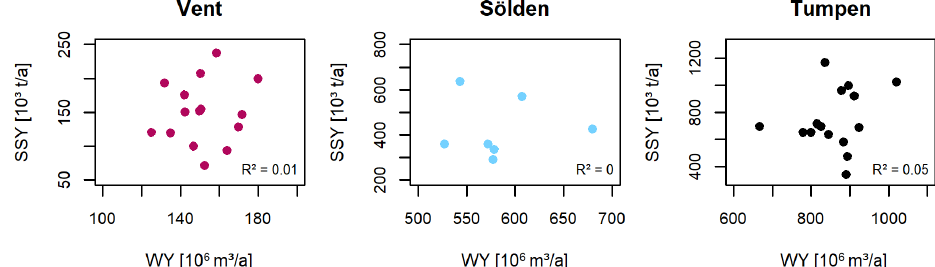
Figure 5. Annual water and suspended sediment yield at the gauges in Vent, Sölden and